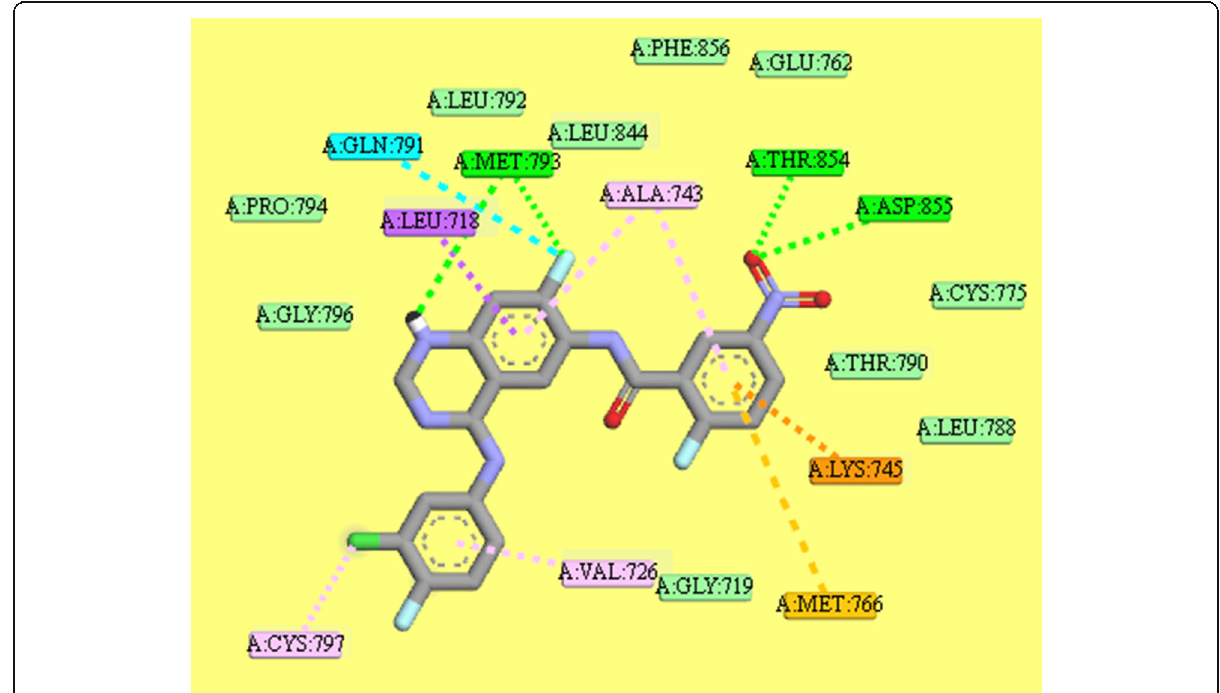
Fig. 2 The 2D interaction of compound 17 in complex with the EGFR